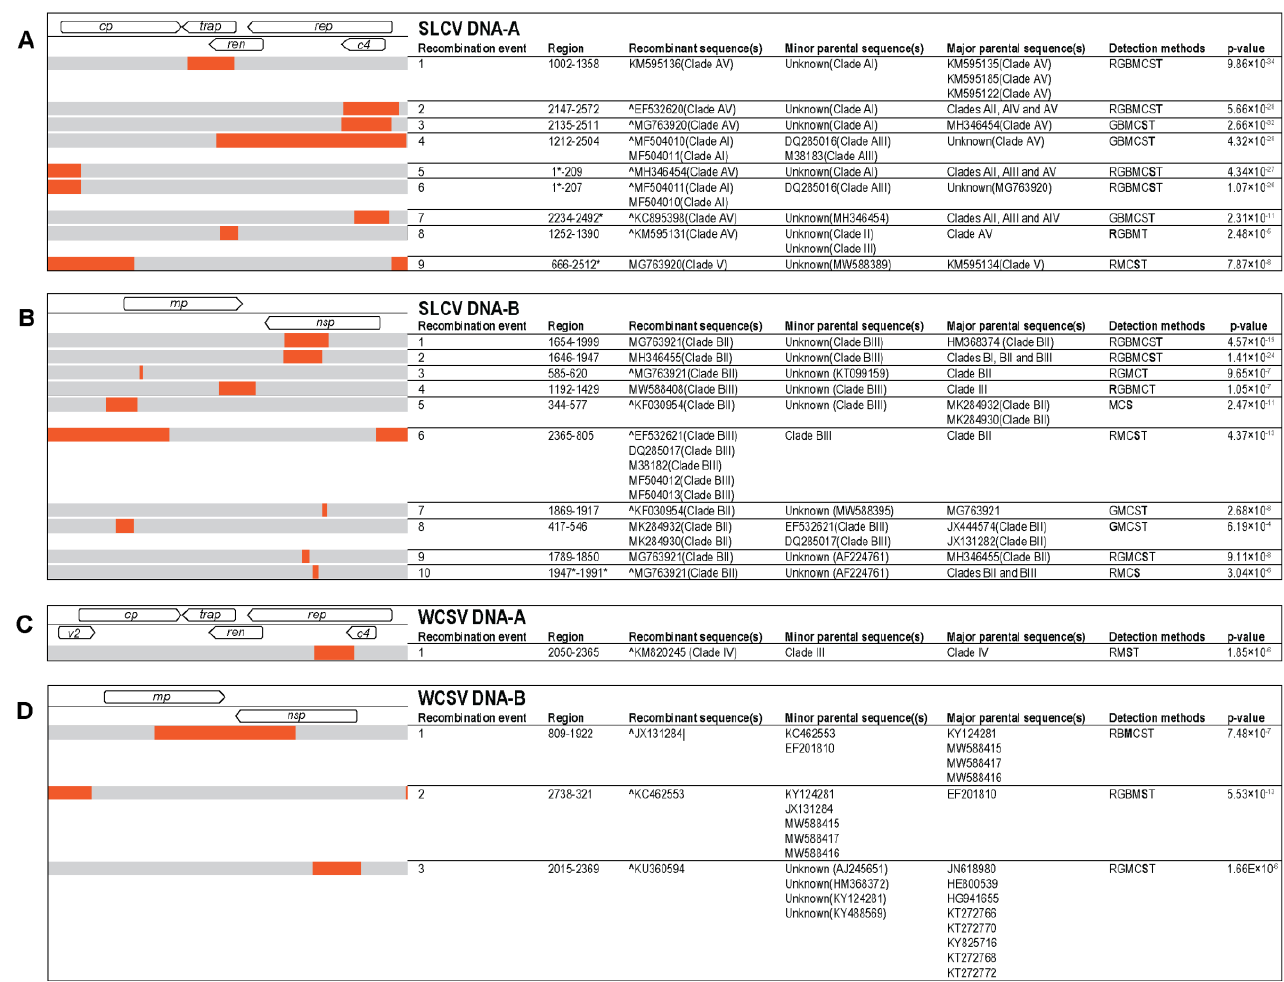
Figure 1. Summary of the recombination events detected in the datasets of ( A ). SLCV DNA-A, ( B ). SLCV DNA-B, ( C ). WCSV DNA-A and D. WCSV DNA-B by RDP5 v.5.5 [33]. The methods used to detect recombination are RDP (R) GENCONV (G), BOOTSCAN (B), MAXCHI (M), CHIMERA (C), SISCAN (S) and 3SEQ (T). The method with the highest p -value for each recombination event is in bold text. Sites where the actual breakpoint is undetermined are marked with *. Recombinant sequences marked with ^ indicated that recombinant sequence may have been misidentified (one of the identified parents might be the recombinant). On the right hand side of the table there is a graphical representation of each genome. Each recombination event is represented in orange relative to the reference genome.